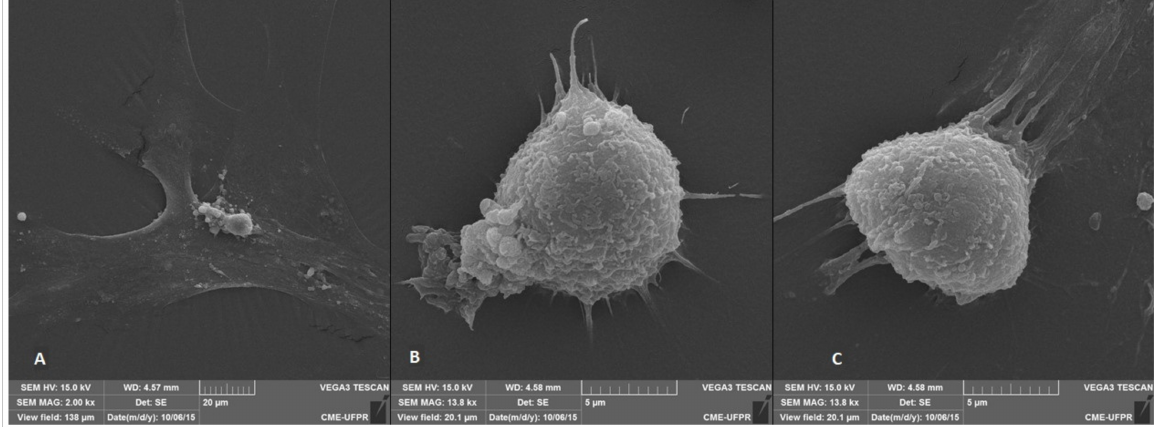
Figure 7. Scanning electron microscopy of WJ-MSC-derived neurospheres. ( A ) undifferentiated WJ-MSC; ( B , C ) neurospheres (Jeol JSM—6360 LV,